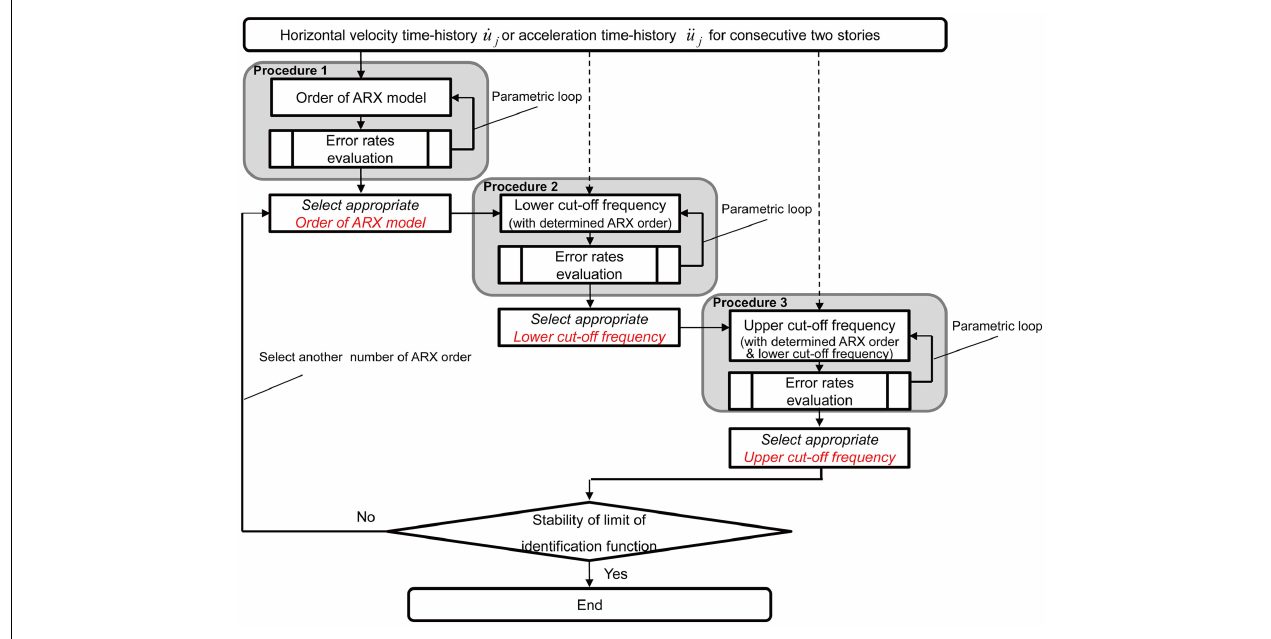
FIGURE 7 | Flowchart of system identification .